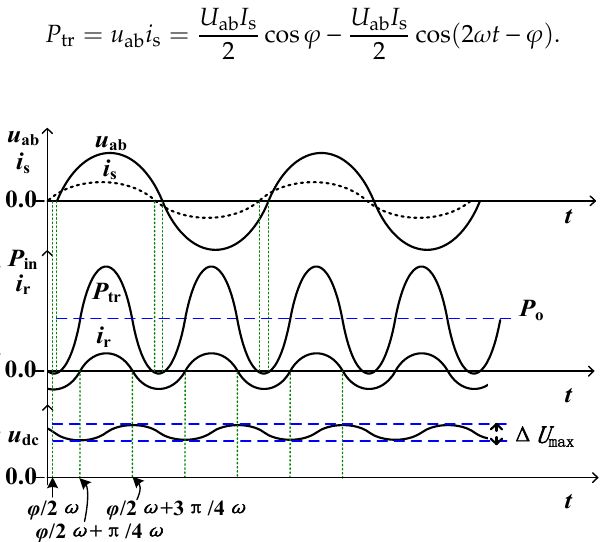
ff erent variables in the Figure 2. Waveforms of different variables in the system. Figure 2. Waveforms of di